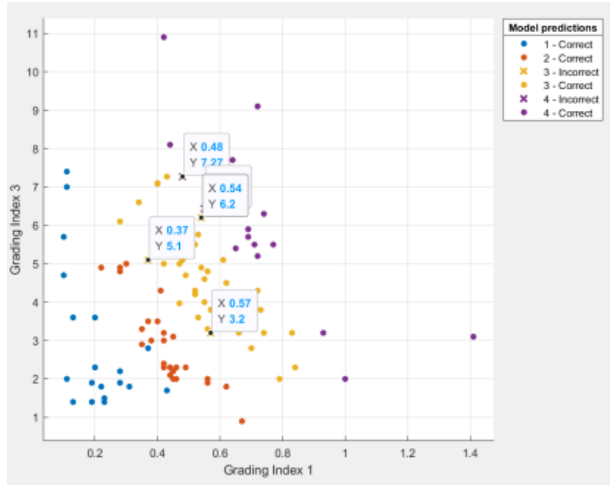
Figure 6. Scatter diagram of prediction results in low dimension (2).